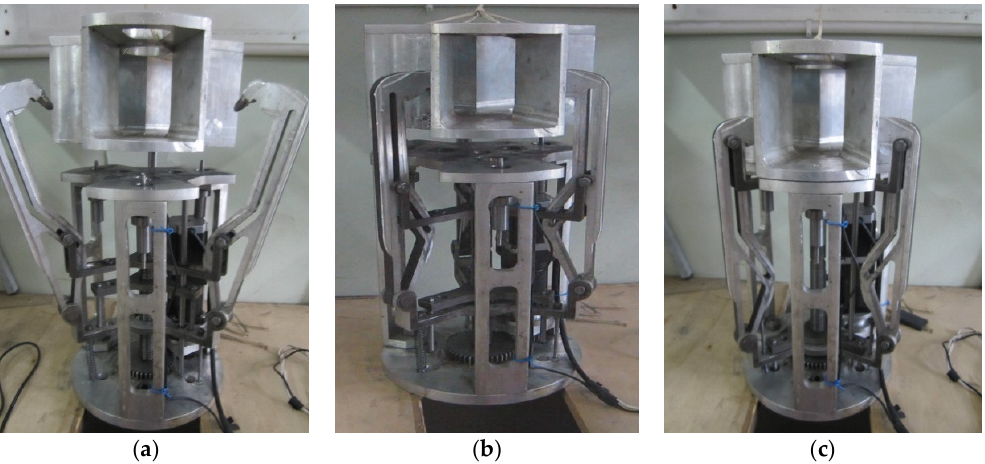
Figure 11. Vertical docking test, ( a ) initial phase of docking; ( b ) claw retraction and drawing in stage; ( c ) docking completed .